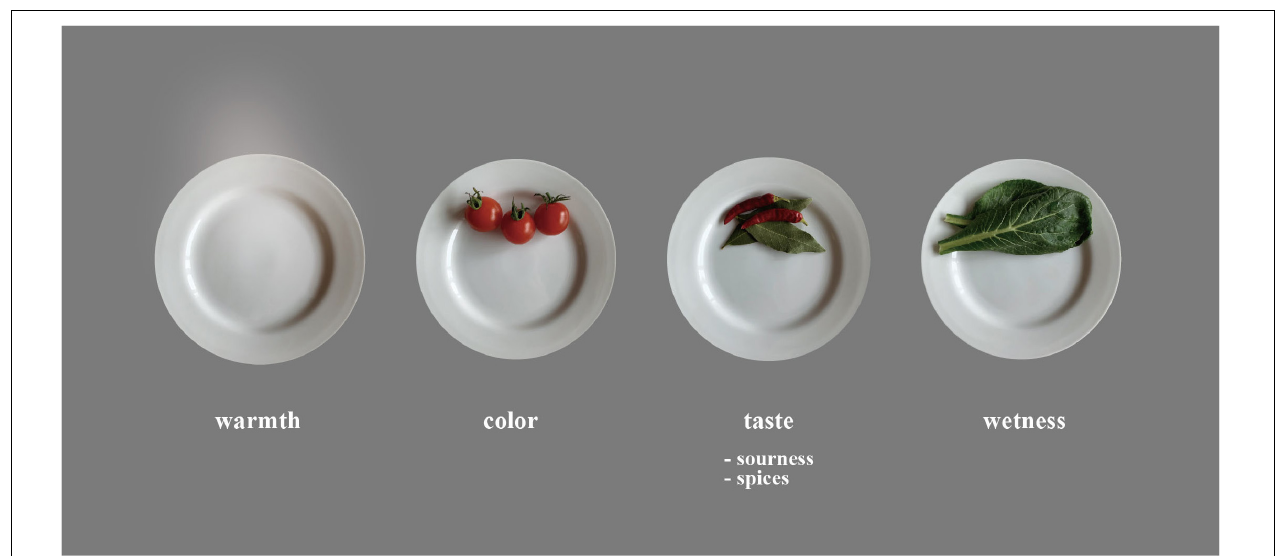
FIGURE 5 | Four representative elements that change the impressions on the main dishes. The results of multivariate analysis showed that color, taste (sourness and spices), and moisture significantly affected the acceptability of a garnish. Additionally, sour and moist types of garnishes balance the taste of the main dish. To stimulate appetite, it is important to make the main dish appear warm, even if it is not